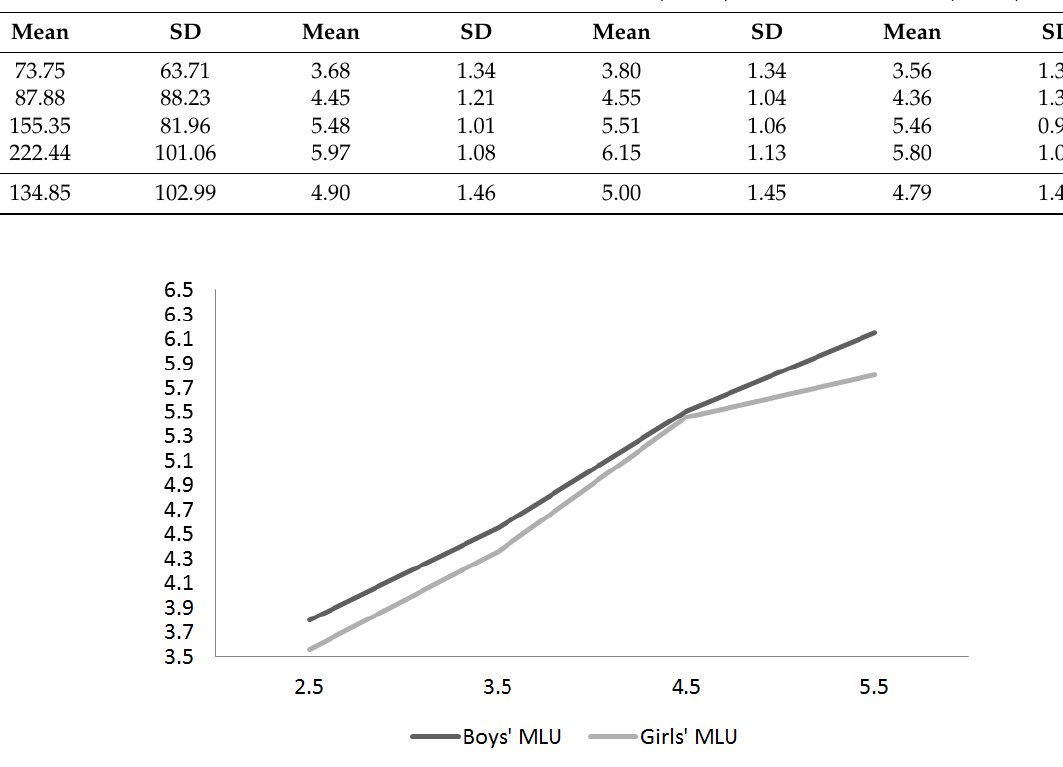
Figure 1. Gender differences in the MLU for the sample (N = 192).